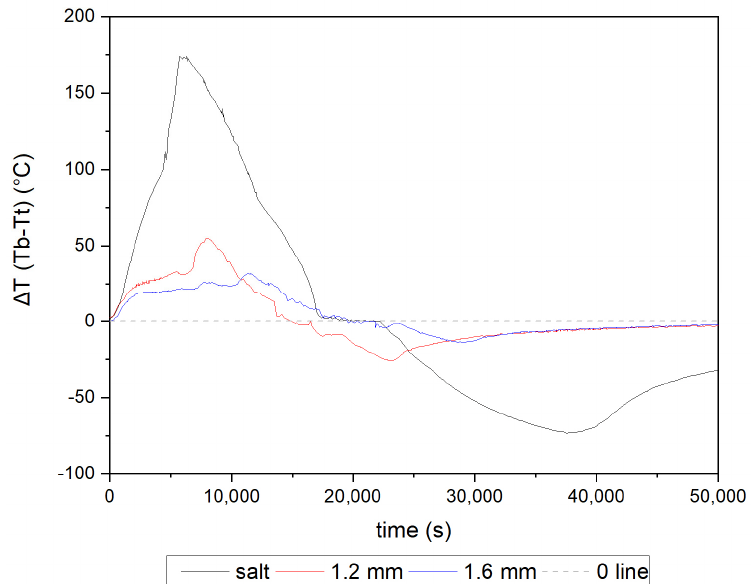
Figure 7. The temperature gradient between the top and bottom thermocouple during the experiment for all tested cases.